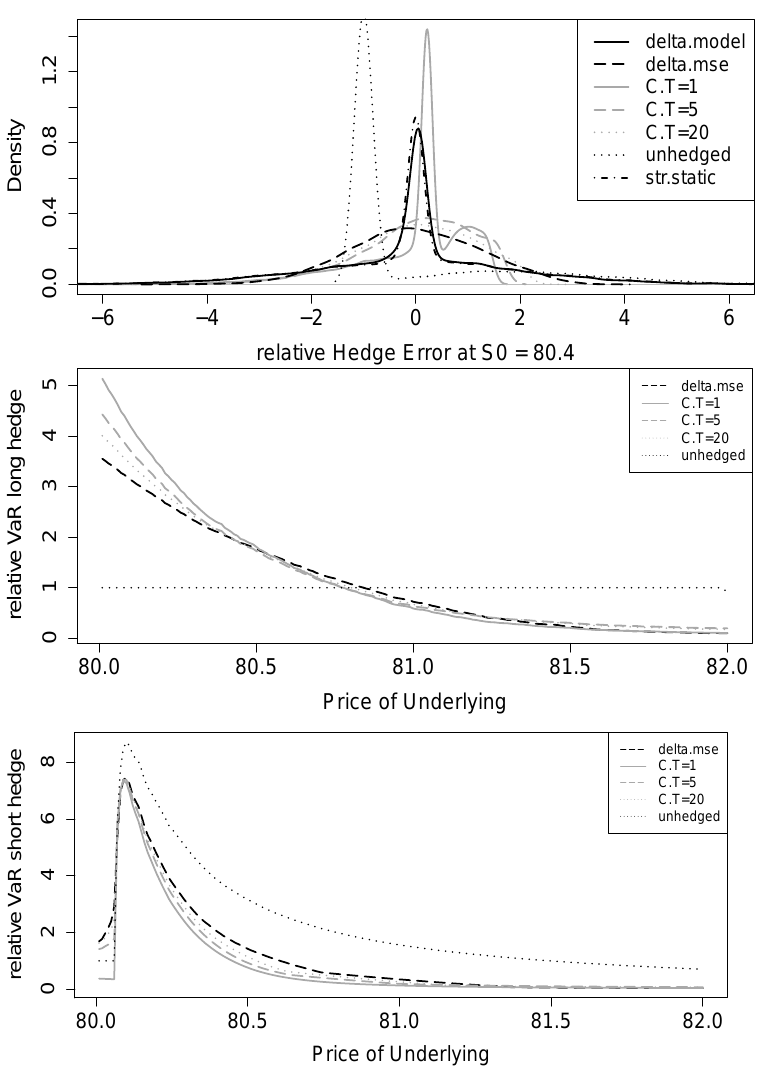
Figure 4. Black–Scholes model with discrete hedging in continuous time: hedge error densities and value-at-risk for long and short hedges. The densities are calculated for an underlying price 0.5% above the barrier. Relative VaR figures refer to the 95% confidence level. Hedging object is a down-and-out put with K = 100, B = 80, and T = 20 days; the hedging period is ∆ t = 1 day. The hedging strategies are standard Black–Scholes delta (delta.model), MSE delta using the underlying (delta.mse), MSE delta using vanilla calls with time to maturity of 1 (C.T = 1), 5 (C.T = 5), and 20 (C.T = 20) days, strike-spread static hedging (str.static), and no hedging